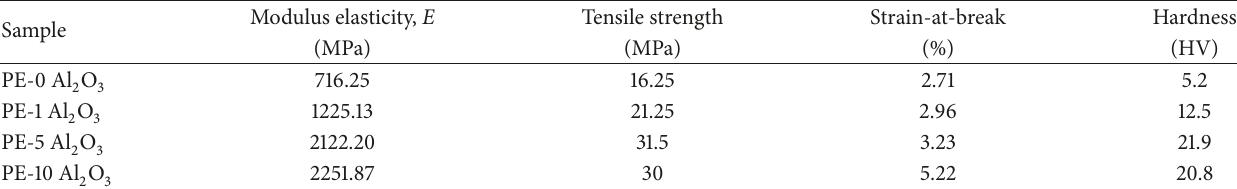
Figure 6: SEM micrographs of cryofractured surfaces of (a) neat polyester; (b) composites with 5 vol% alumina; and (c) composites with 10 vol% alumina. Table 3: Mechanical properties of polyester/alumina